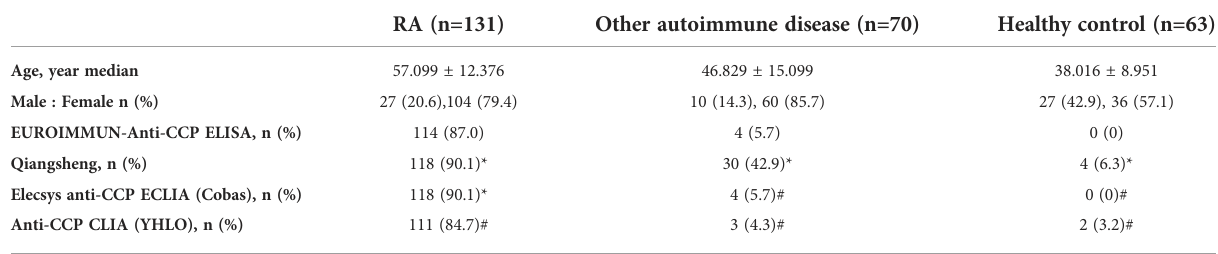
Table 2 Patient demographics and anti-CCP positivity.